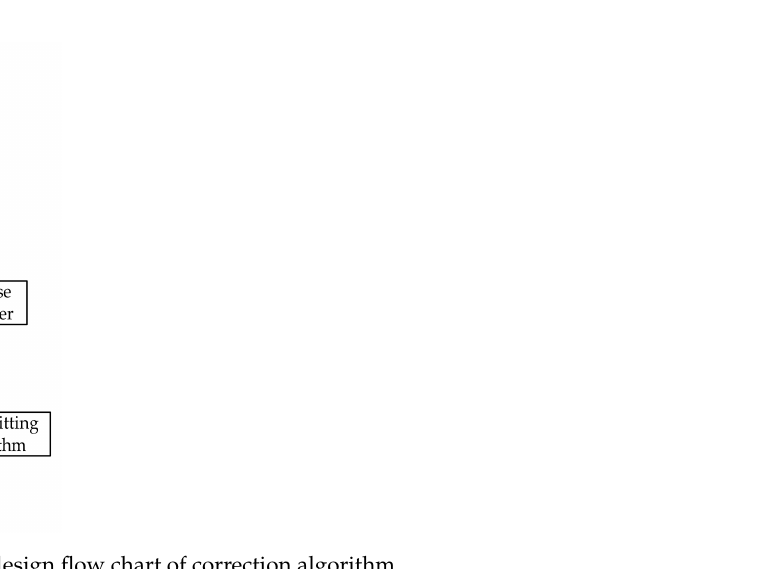
Figure 21. Software design flow chart of correction algorithm.